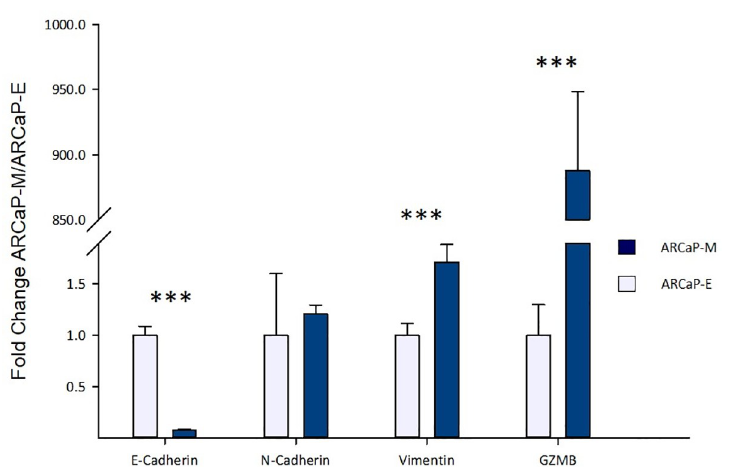
Fig 1. The relative gene expression of epithelial-mesenchymal transition (EMT) markers and GZMB in ARCaP-E (n = 3) and ARCaP-M (n = 3) using qRT-PCT. The samples are normalized against endogenous control (GAPDH). These results show approximately 900-fold higher gene expression of GZMB in ARCaP-M compared to ARCaP-E. Asterisks indicate statistical significance ( ��� : p-value < 0.001).